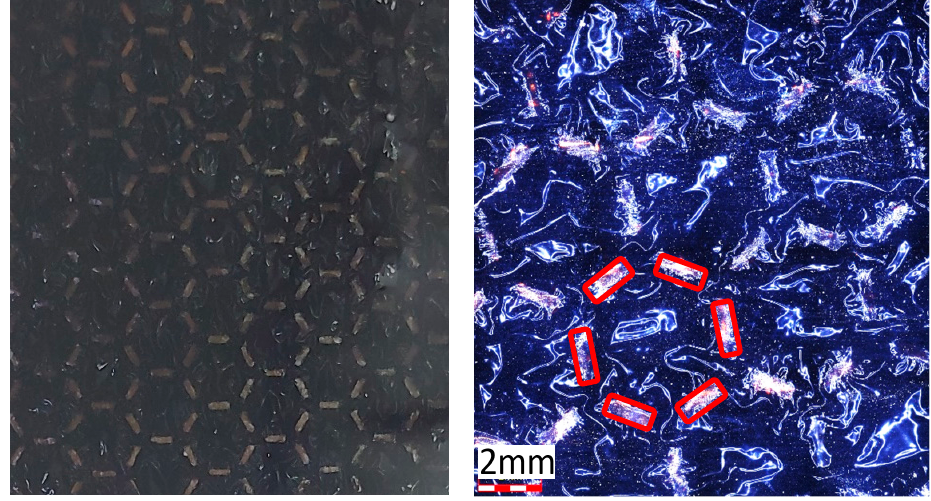
Figure 2. Optical microscope image of crosslinked LLDPE with nacre pattern geometry.